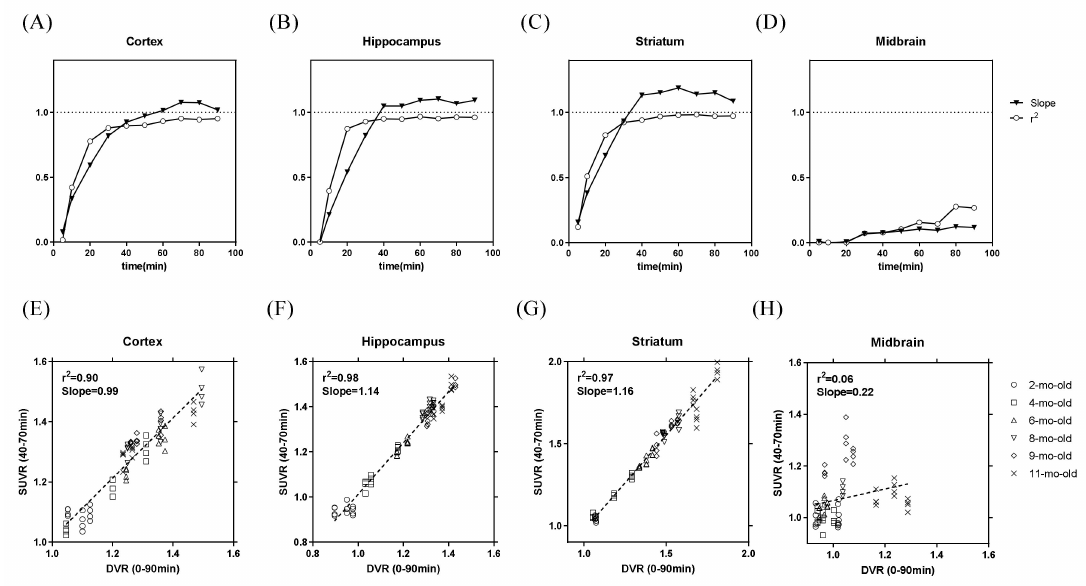
Figure 3. The r 2 value and slope of the regression between the distribution volume ratios (DVR) and the standardized uptake value ratio (SUVR) measured at various time intervals in ( A ) cortex, ( B ) hippocampus, ( C ) striatum, and ( D ) midbrain. Correlation between DVR to SUVR at the time interval between 40–70 min post-injection for all age groups in ( E ) cortex, ( F ) hippocampus, ( G ) striatum, and ( H )